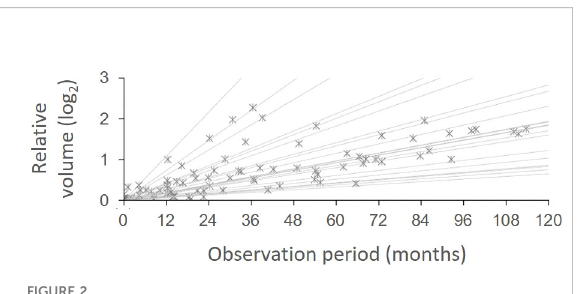
FIGURE 2 Growth patterns of unirradiated vestibular schwannomas. The relative volume change during the observation period was fi tted using linear regression for each case [R 2 , 0.965 (IQR, 0.937- 0.991)]. The volume of unirradiated lesions exponentially expanded with a doubling time of 62.2 (IQR, 30.6-92.3) months, which corresponds to a relative volume increase of 14.0% (IQR, 7.8-27.0%) per